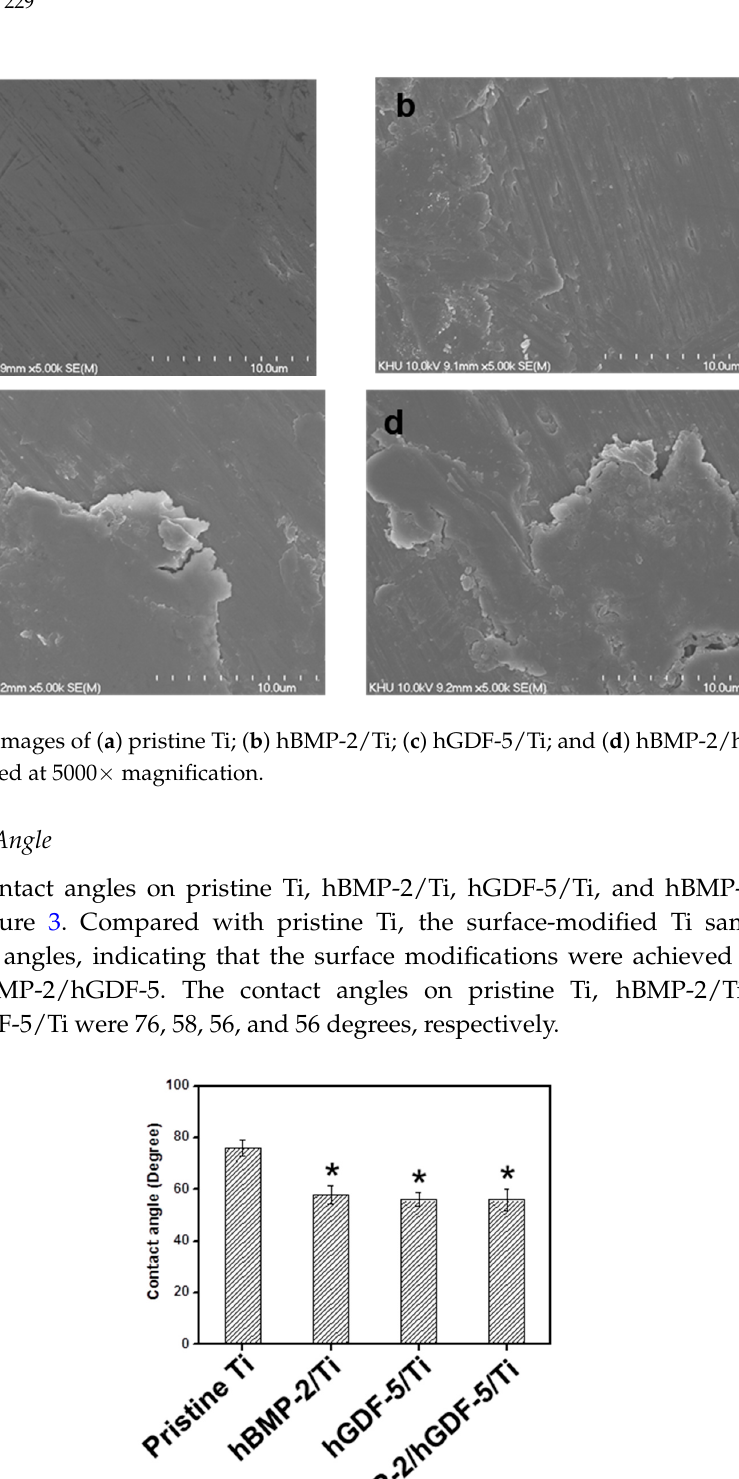
3 of 16 Figure 1. XPS spectra of ( a ) pristine Ti; ( b ) hBMP-2/Ti; ( c ) hGDF-5/Ti; and ( d ) hBMP-2/hGDF-5/Ti samples, as monitored from 100 to 800 eV. 2.2. Surface Morphology Figure 2 shows the surface morphologies of pristine Ti, hBMP-2/Ti, hGDF-5/Ti, and hBMP- 2/hGDF-5/Ti. Compared with hBMP-2/Ti, hGDF-5/Ti, and hBMP-2/hGDF-5/Ti, a smooth surface